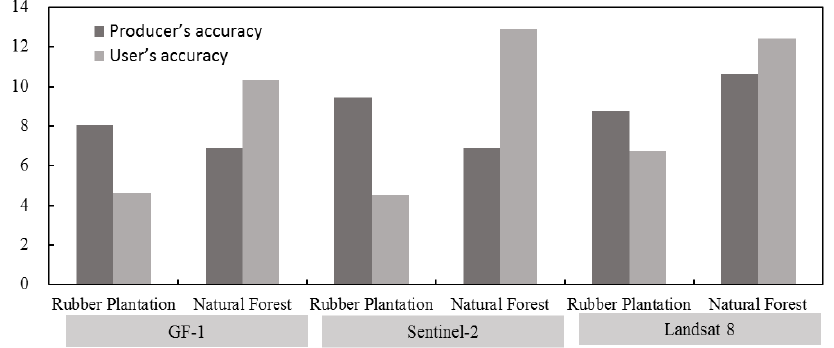
Figure 7. Accuracy changes before and after adding textural features.